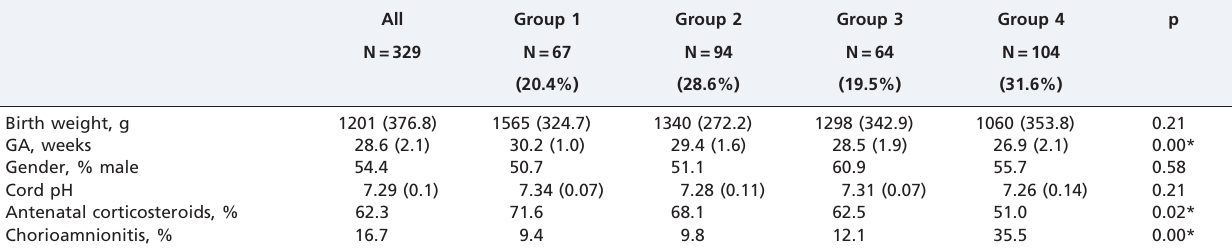
Table 1 - The characteristics of the study population by the initial airway-management modality. The results are expressed as the mean (SD).